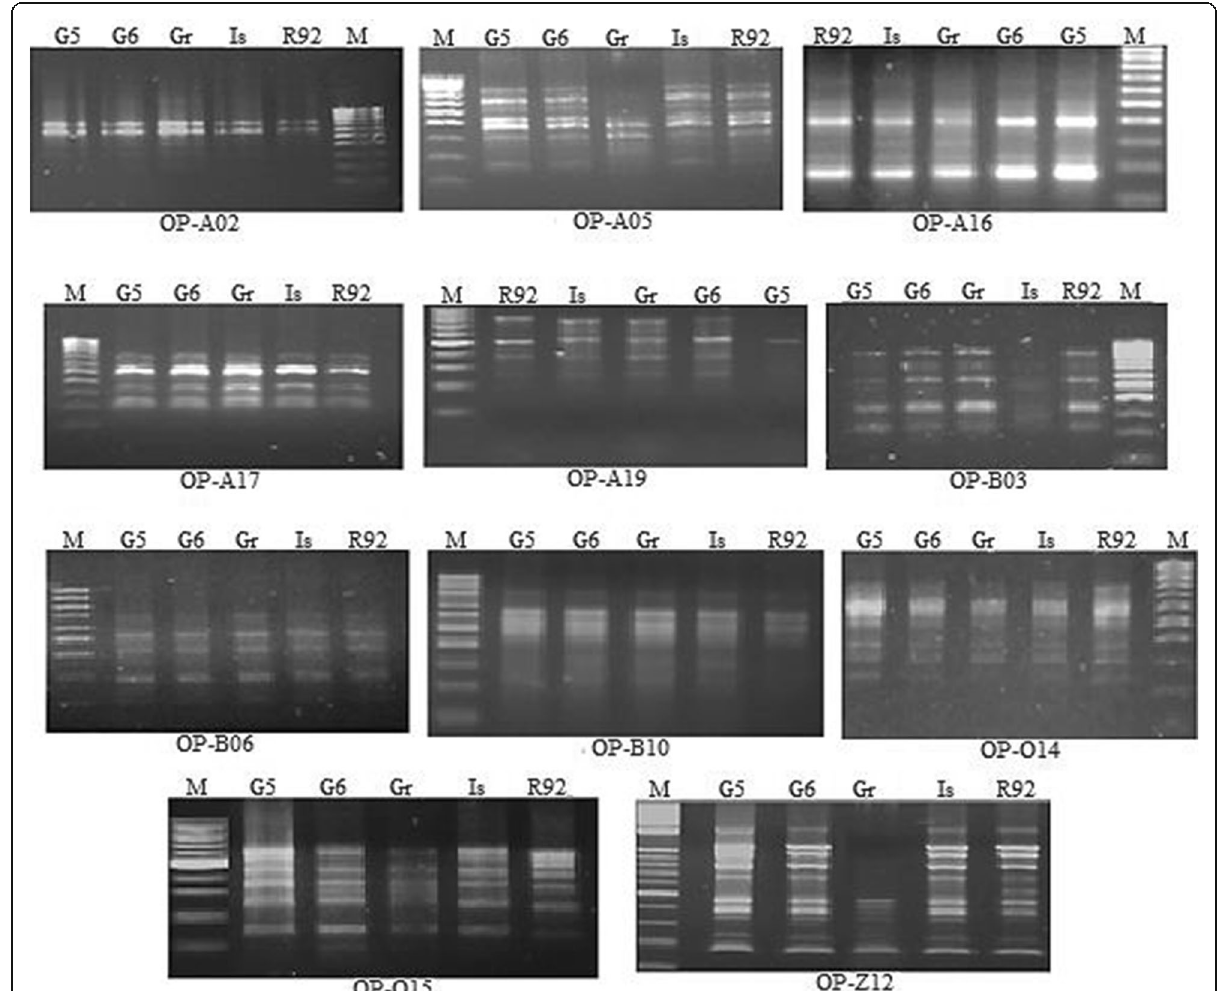
Fig. 1 RAPD-PCR fragments of the 11 primers with five peanut cultivars. M marker, G5 Giza-5, G6 Giza-6, Gr Gregory, Is Ismailia-1 and